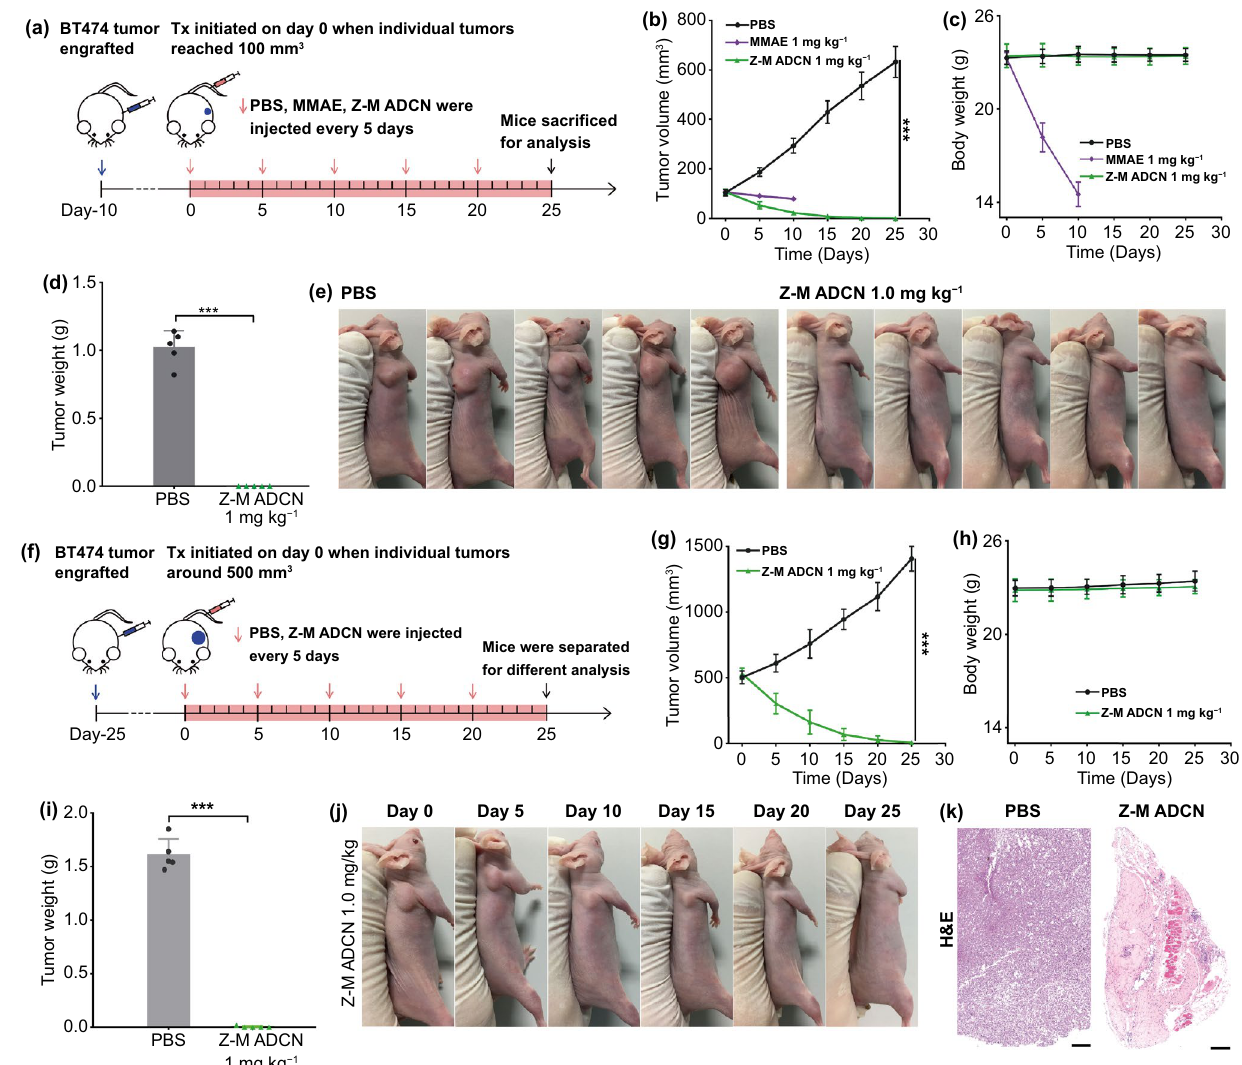
Fig. 6 Antitumor efficacy of Z-M ADCN against small and large BT474 tumor models. The initial volumes of tumors in these trials were about 100 mm 3 ( a–e ) and 500 mm 3 ( f–k ). a Schematic illustrating of the small tumor experiment. b Tumor growth curves of each group after the i.v. injection of PBS, MMAE (1 mg kg −1 ), Z-M ADCN (MMAE-equiv. dose, 1 mg kg −1 ) once every five days for five times. c Body weight changes during the treatment. d The average tumor weight of each group after total experiment. e Images of the BT474 xenograft-bearing mice after different treatments at endpoint of the experiment. f Schematic illustrating of the large tumor experiment. g Tumor growth curves of each group after the treatment of PBS or Z-M ADCN (MMAE-equiv. dose, 1 mg kg −1 ) once every five days for five times. h Body weight changes during the treatment. i The average tumor weight of each group after total experiment. The residual tumors were resected on day 25. j Images of a representative mouse (the tumor volume was around 500 mm 3 ) with the treatment of Z-M ADCN (MMAE-equiv. dose, 1 mg kg −1 ) during the 25-day evaluation period. k H&E analysis of tumor tissues which were collected on day 25. Scale bars: 200 μm. Data are presented as the mean ± s.d. ( n = 5 mice). Statistical significance: *P < 0.05, **P < 0.01, ***P <